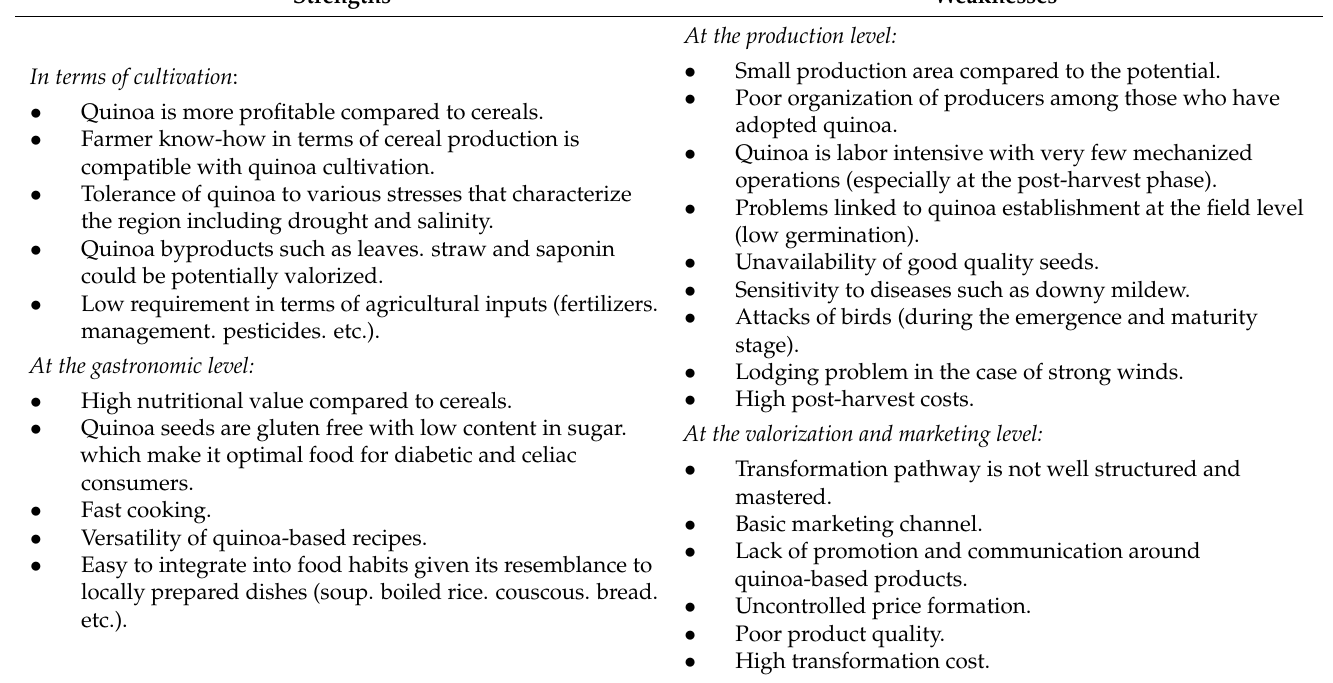
Table 8. SWOT (strength. weaknesses. opportunities and threats) analysis of the quinoa value chain in Morocco. Strengths